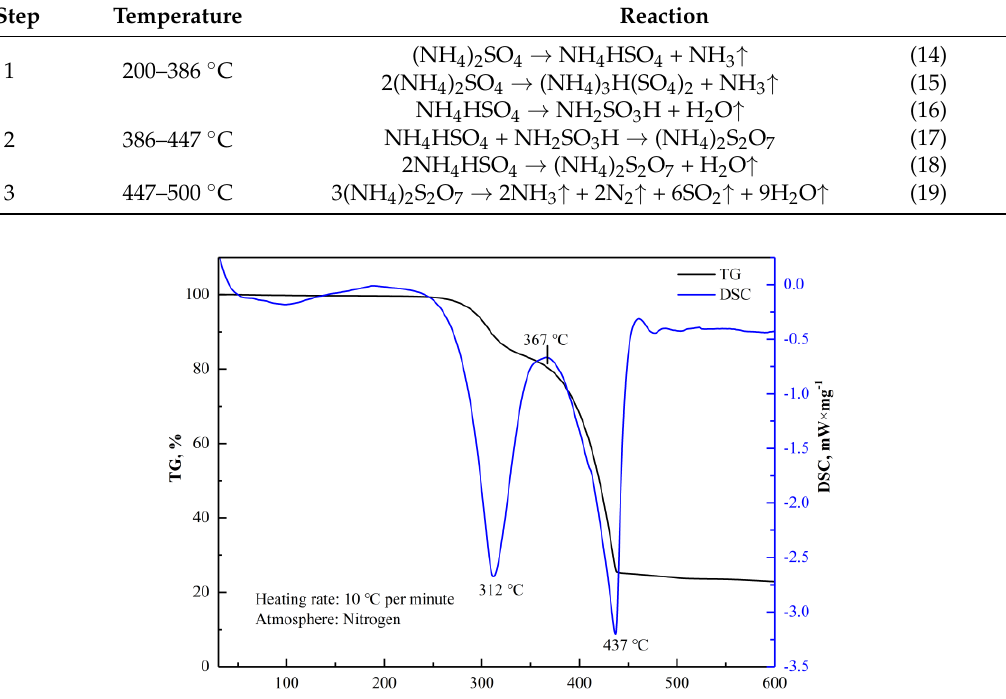
Figure 13. The TG-DSC curve of the mixture of magnetic separation tailings and (NH 4 ) 2 SO 4 in mass ratio of 4:1.